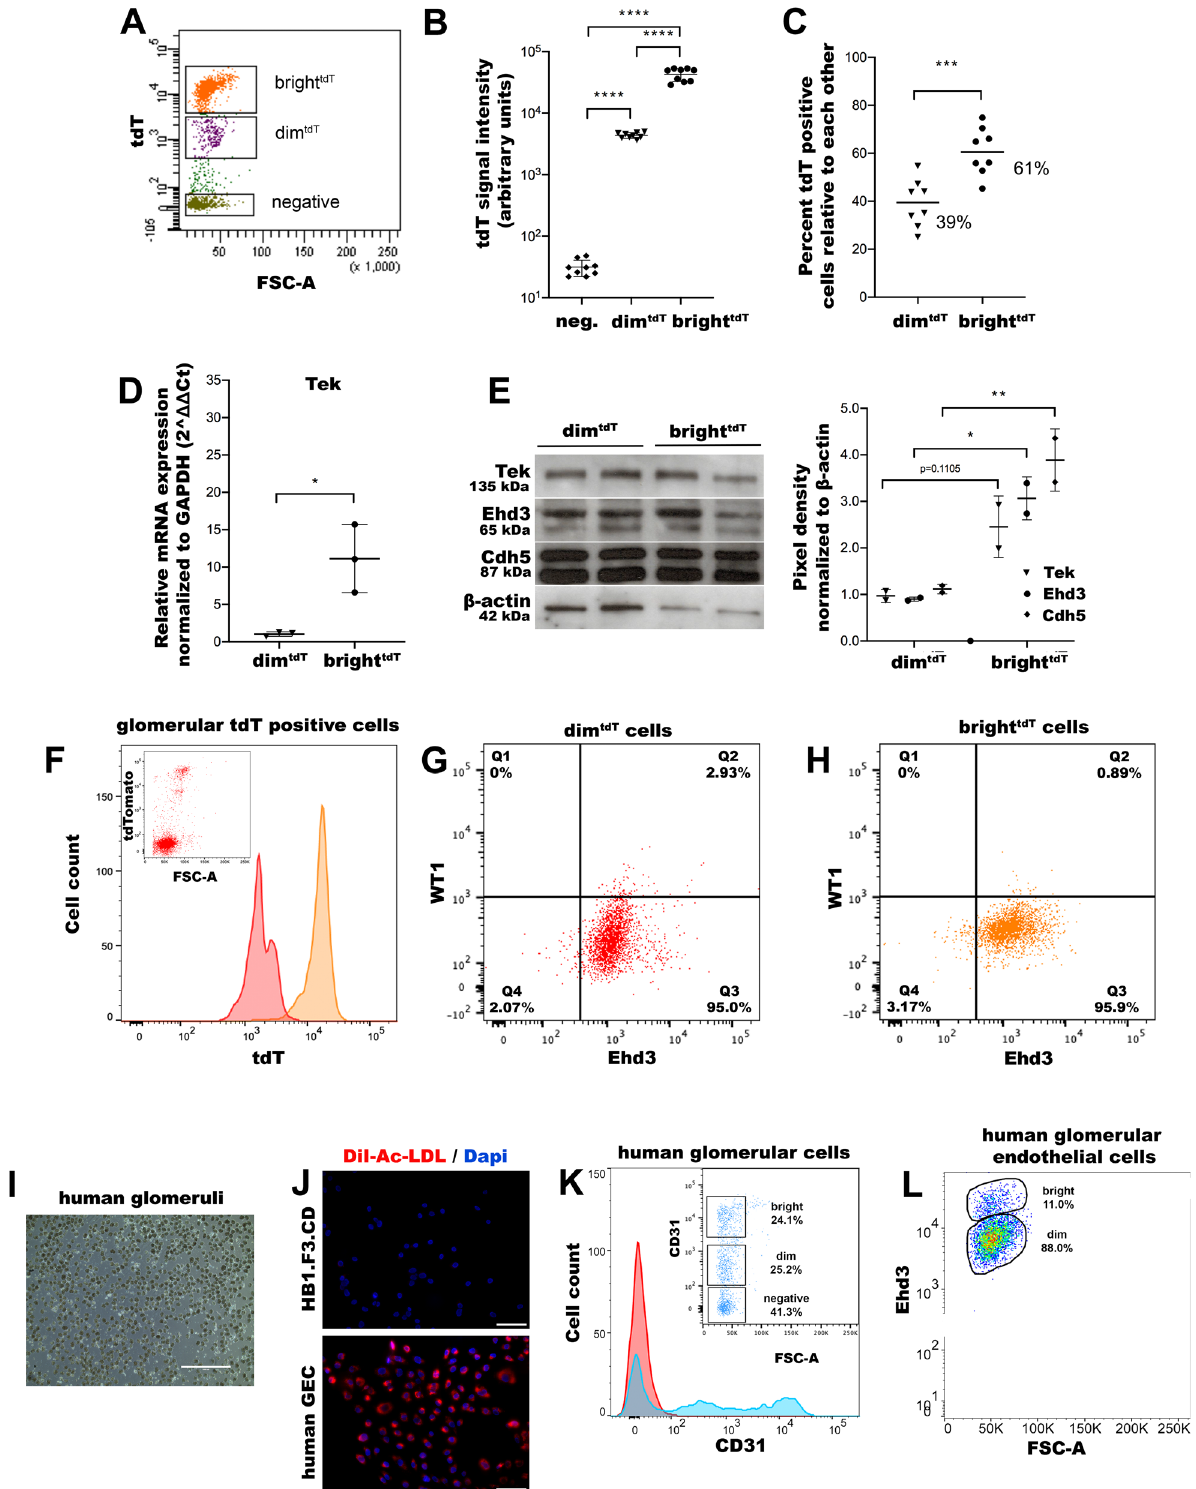
Figure 2. Characterization of glomerular tdTomato positive cells by flow cytometry. ( A) Representative dot plot image of the bright tdT and dim tdT subpopulations as detected using the DB FACSCanto II flow cytometer. ( B, C) Dot plots showing median intensities of the tdT signal in the negative, dim tdT and bright tdT cells ( B ) and relative percent compositions of dim tdT (39%) and bright tdT (61%) GEC subpopulations in the WT glomeruli as determined based on the total number of gated tdT positive cells (biological replicates, n = 8/group; see gating strategies in supplementary Fig. 6) ( C ). ( D) Dot plots showing RT-qPCR analysis of Tek expression from dim tdT and bright tdT GEC normalized to GAPDH according to the 2∆∆ Ct method; biological replicates, n = 3 mice/ group. € Representative immunoblots for Tek (135 kDa), Ehd3 (65 kDa) and Cdh5 (87 kDa) from dim tdT